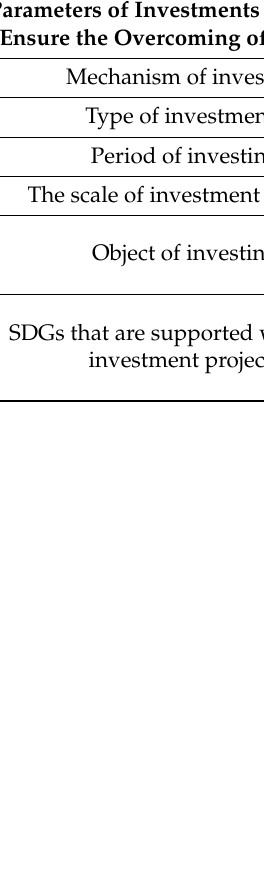
Table 7. The essence of investments in the new (alternative) approach to financial risk management amid the economic crisis, based on corporate social